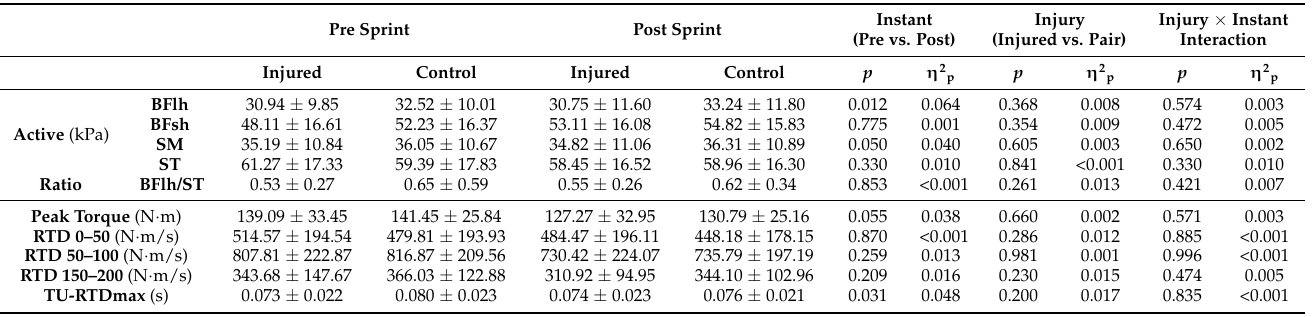
Table 1. Acute effects of a sprint protocol in limbs with previous hamstring injury history (n = 34) vs. healthy control players (n = 65) using age as a covariate on the active shear modulus and neuromuscular